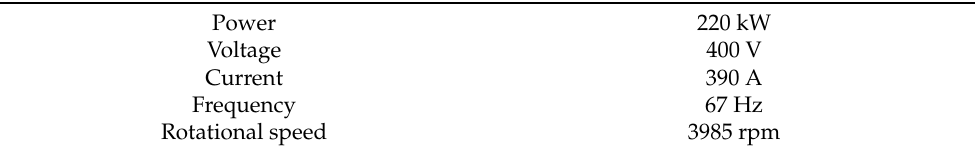
Table 1. Tested motor